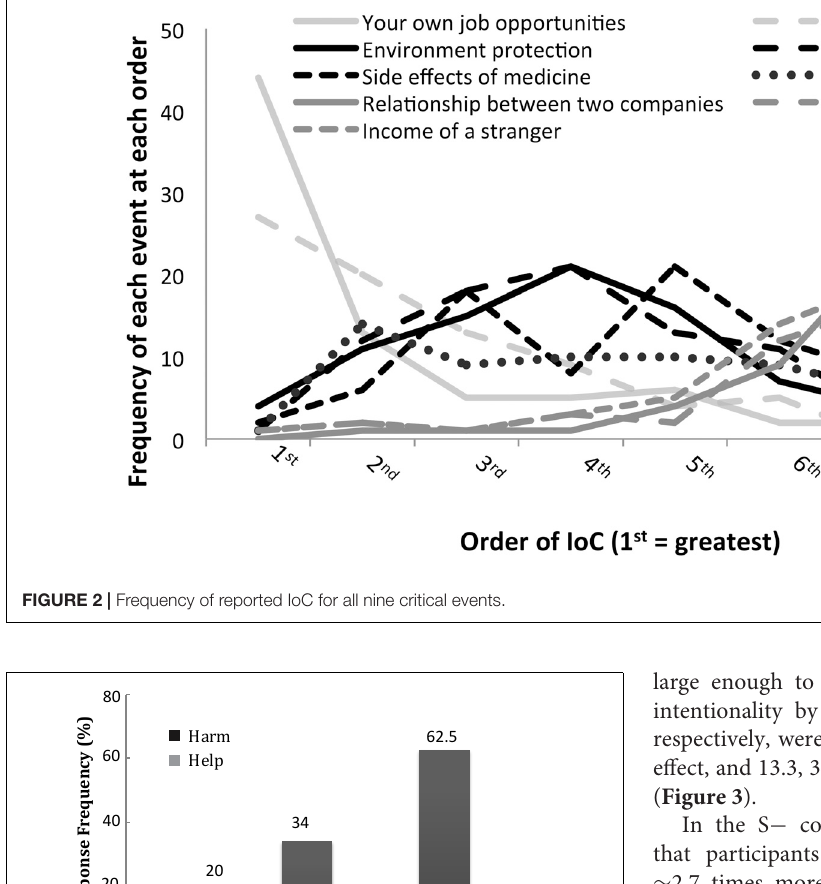
(35.8%, 29 out of 81) than intentionally helped the environment (8.6%, 7 out of 81); X 2 ( 1 ) = 17.29; p < 0.001. This is